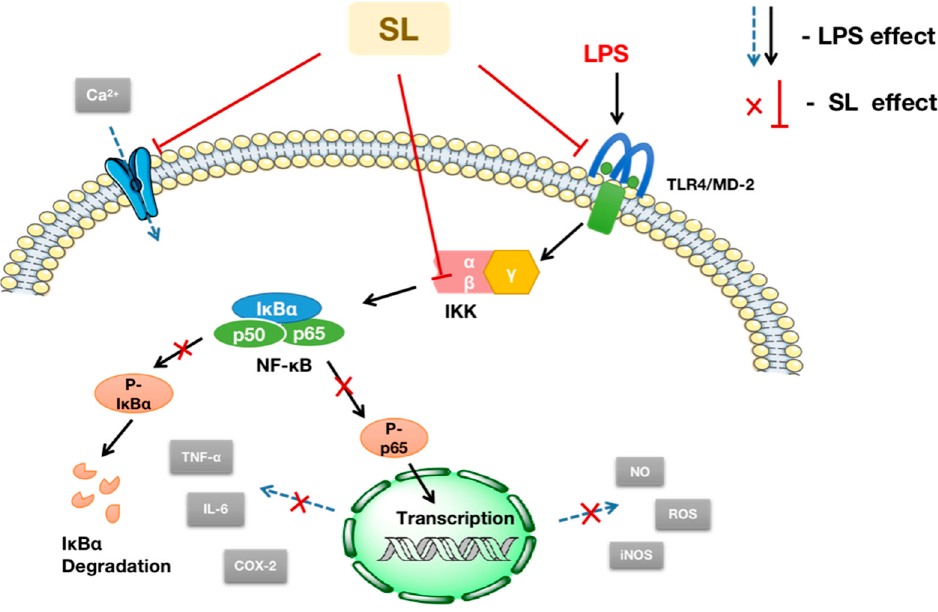
Figure 9. Schematic illustration of the anti-inflammatory action and mechanism of SL in a macrophage RAW264.7 Cells.